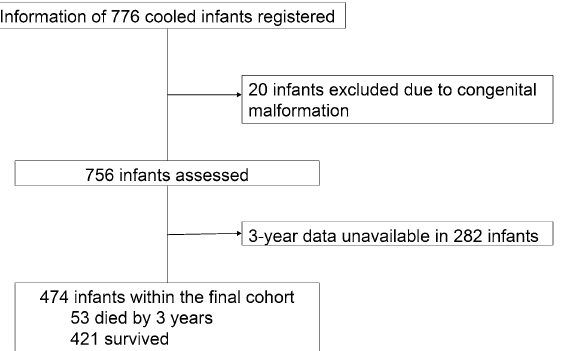
Figure 1. Profile of the study population. A diagram depicting the flow of the study population.